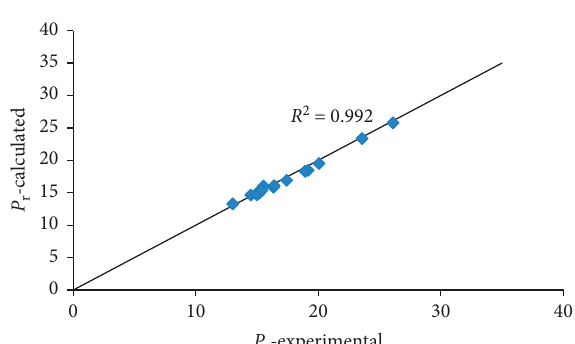
Figure 7: Experimental and calculated values of CO permeability for emim[Tf2N] Table 8: Modified parameters for the SAPO-34 volume fraction